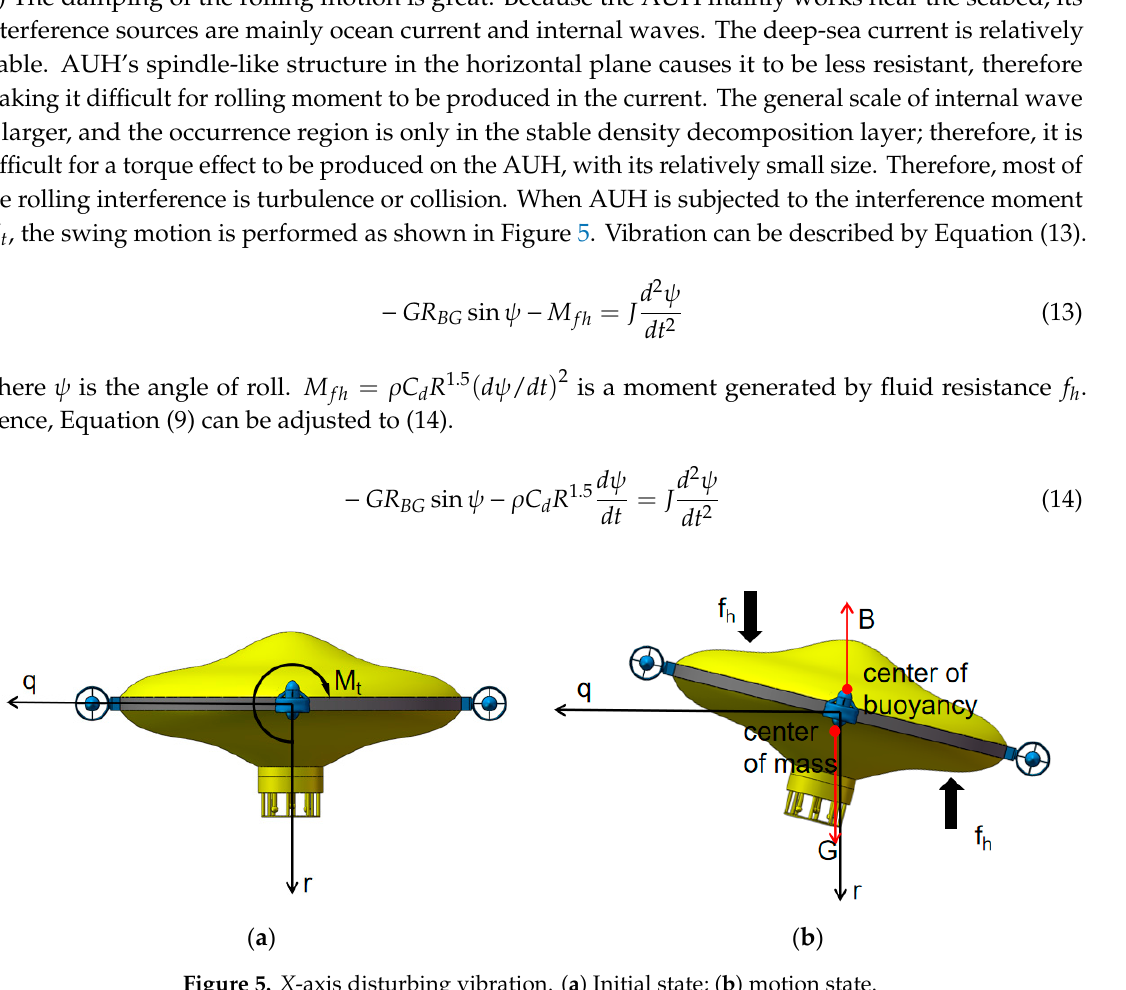
Figure 5. X -axis disturbing vibration. ( a ) Initial state; ( b ) motion state.